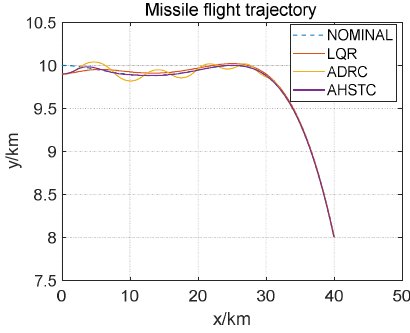
Figure 4. Trajectory tracking curve.